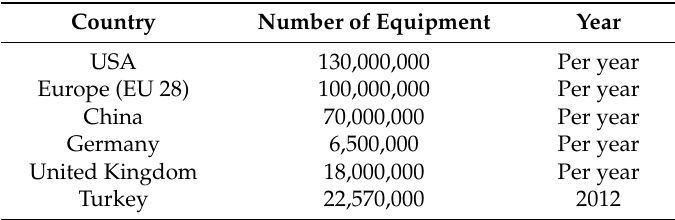
Table 1. Generation of waste mobile phone in some countries or regions